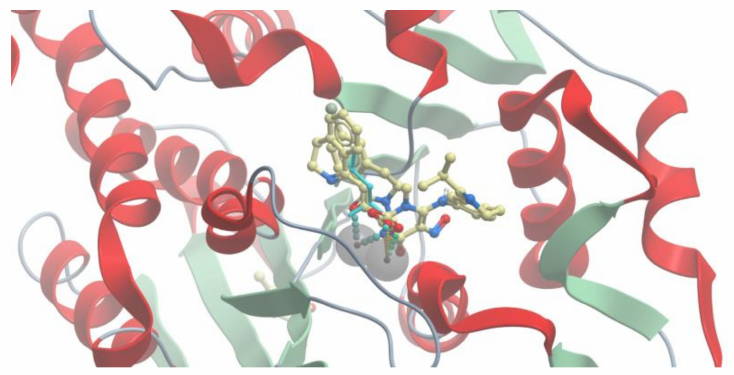
Figure 5. Compounds after docking with Lead Finder are placed similarly to the pose of leucine in the binding site of leucine aminopeptidase; leucine (cyan) is